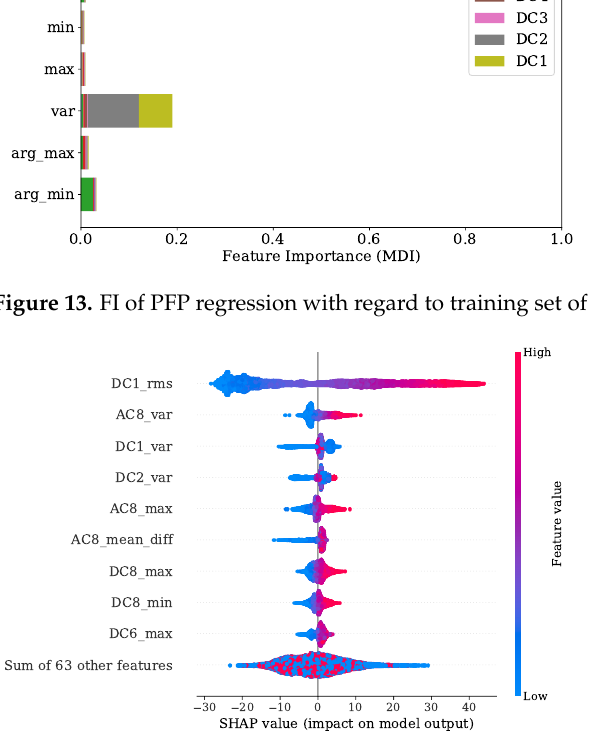
Figure 14. SHAP values summary of PFP regression with regard to training set of engine